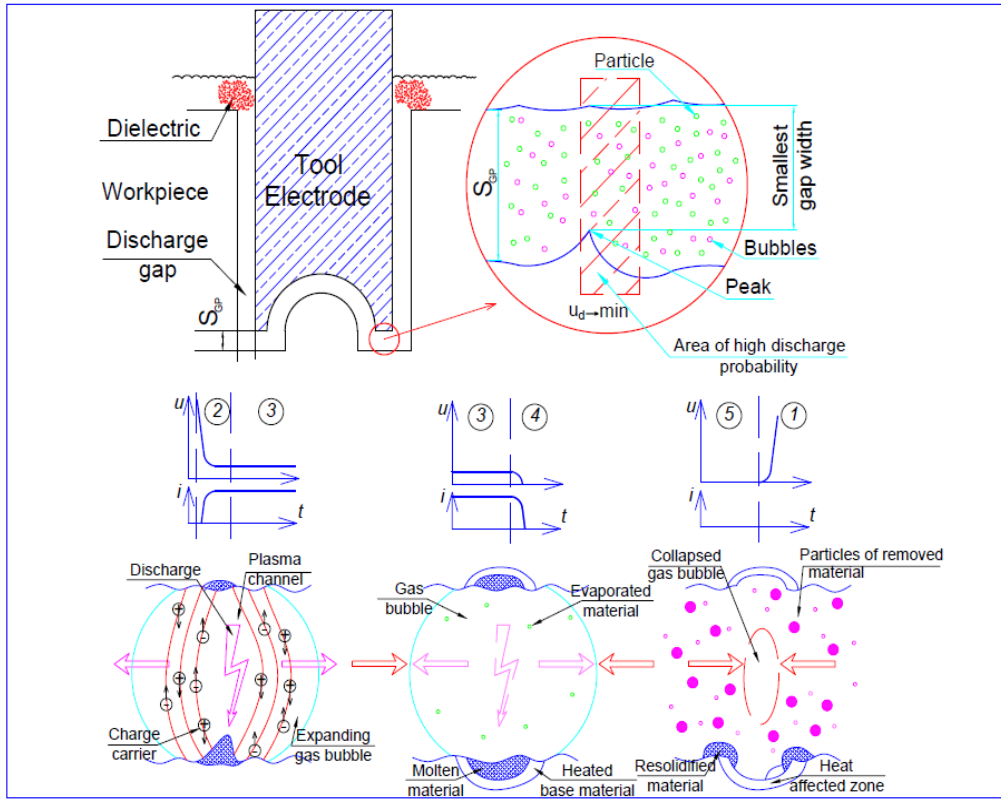
Figure 7. Machining principles of EDM [55].